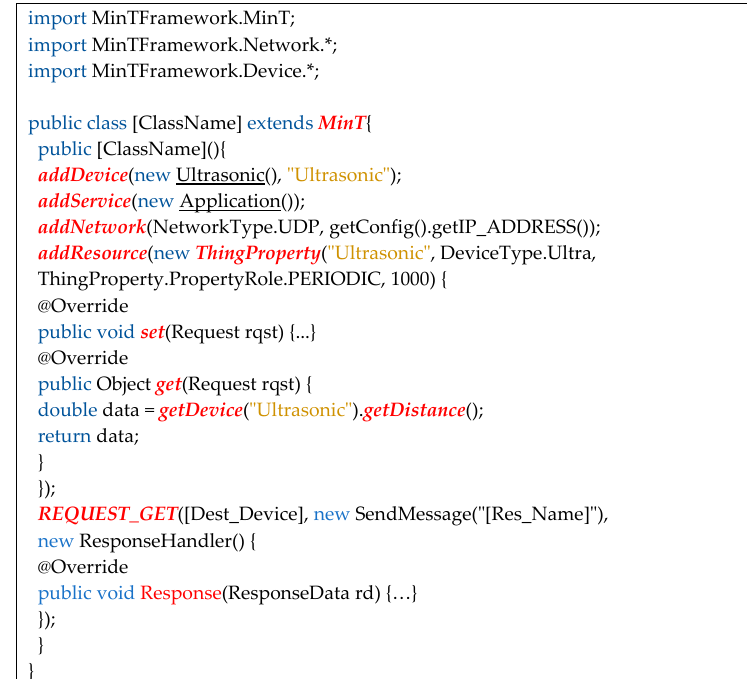
Figure 12. IoT device application development using MinT.